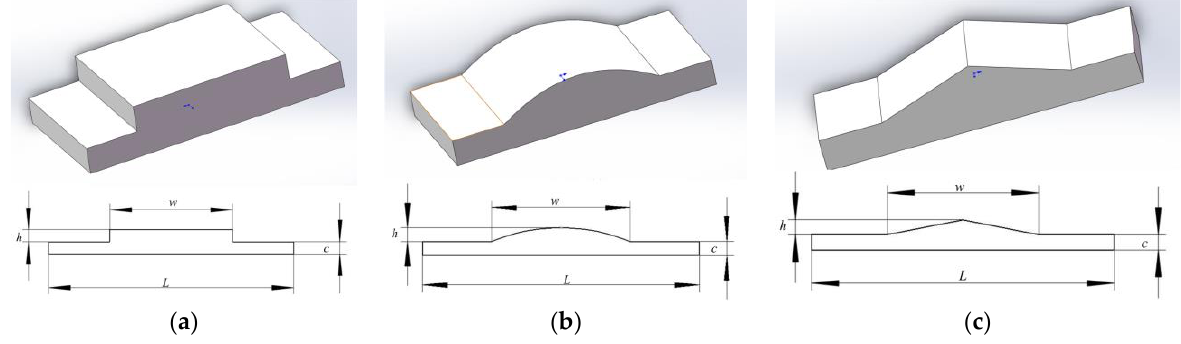
Figure 2. Microtexture Analysis Unit. ( a ) Rectangular element and its cross-sectional size; ( b ) Arc-shaped element and its cross-sectional size; ( c ) Triangular element and its cross-sectional size.